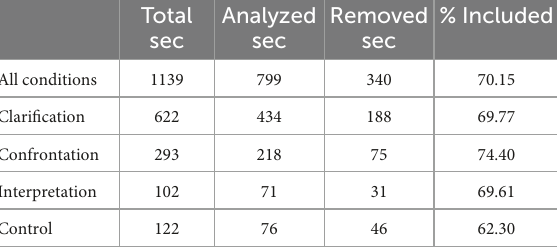
TABLE 2 Report of the interview length in seconds for the interventions assessed by the experts.